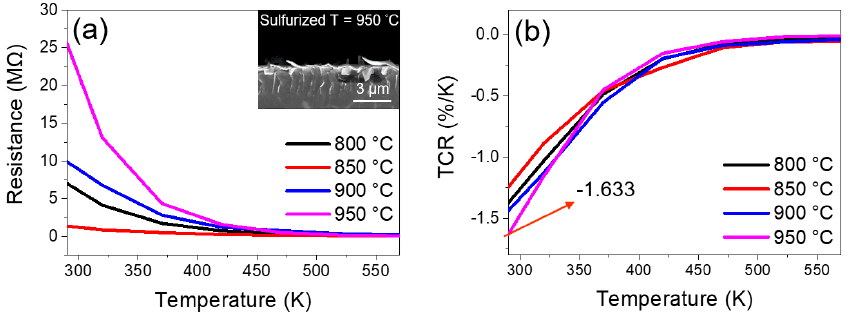
Figure 5. ( a ) The resistance as a function of measured temperature for the Mo x W 1 − x S 2 thin films sulfurized at various temperatures. The insert shows a cross-section SEM image of the Mo x W 1 − x S 2 thin film sulfurized at 950 °C. ( b ) The corresponding TCR values of the samples obtained from ( a ).